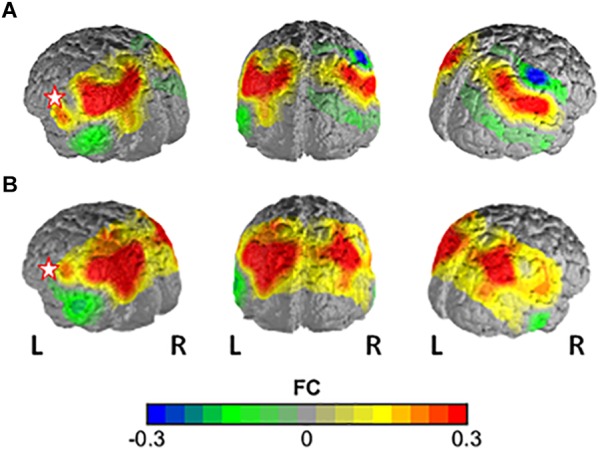
Difference in FC between the high-vital and the regular-vital group with (A) channel 1 (PSC) and (B) channel 11 (lSC) as seed regions. Warm colors indicate higher FC with seed in high-vital vs. regular-vital participants.